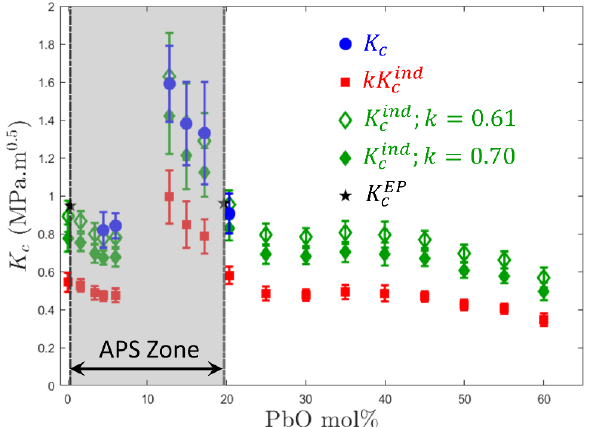
Figure 17. Fracture Toughness as a function of the PbO mol% in PbO-B 2 O 3 glasses: blue circles for fracture toughness K c by three-point bending tests from [143]; red squares for relative fracture toughness values kK ind c by indentation in [143,144]; open and closed green diamonds for K ind c calculated from kK ind c with k = 0.61 [143] and k = 0.70 [144], respectively; and black stars for estimated K c values from [141] for tie-line end members (corresponding to 0.31 mol% PbO (1 wt% PbO) to 19.68 mol% PbO (44 wt% PbO)). Data presented in Table